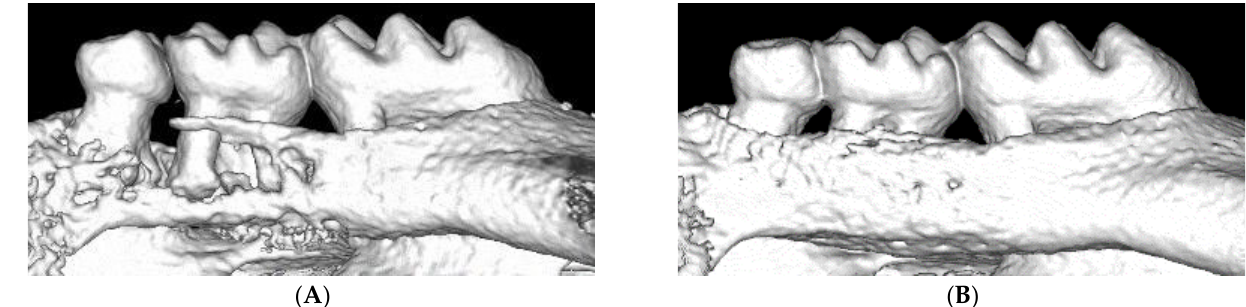
Figure 1. Healing of alveolar bone resorption without treatment in ligation-induced periodontitis in mice. A ligature was placed around the maxillary second molar in 10-week-old male C57BL/6 mice (wild-type, WT) for seven days. Micro-CT evaluation showed natural healing of alveolar bone loss after removal of ligature. ( A ) Before ligature removal ( B ) Seven days after ligature removal.